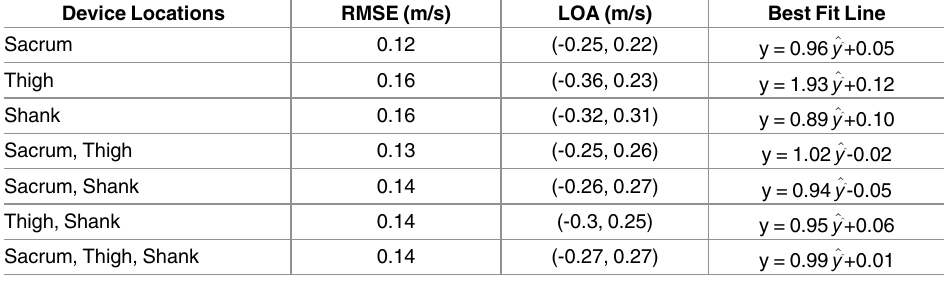
Metrics include the root-mean-squared-error (RMSE), Bland-Altman limits of agreement (LOA), and the best fit line from the regression